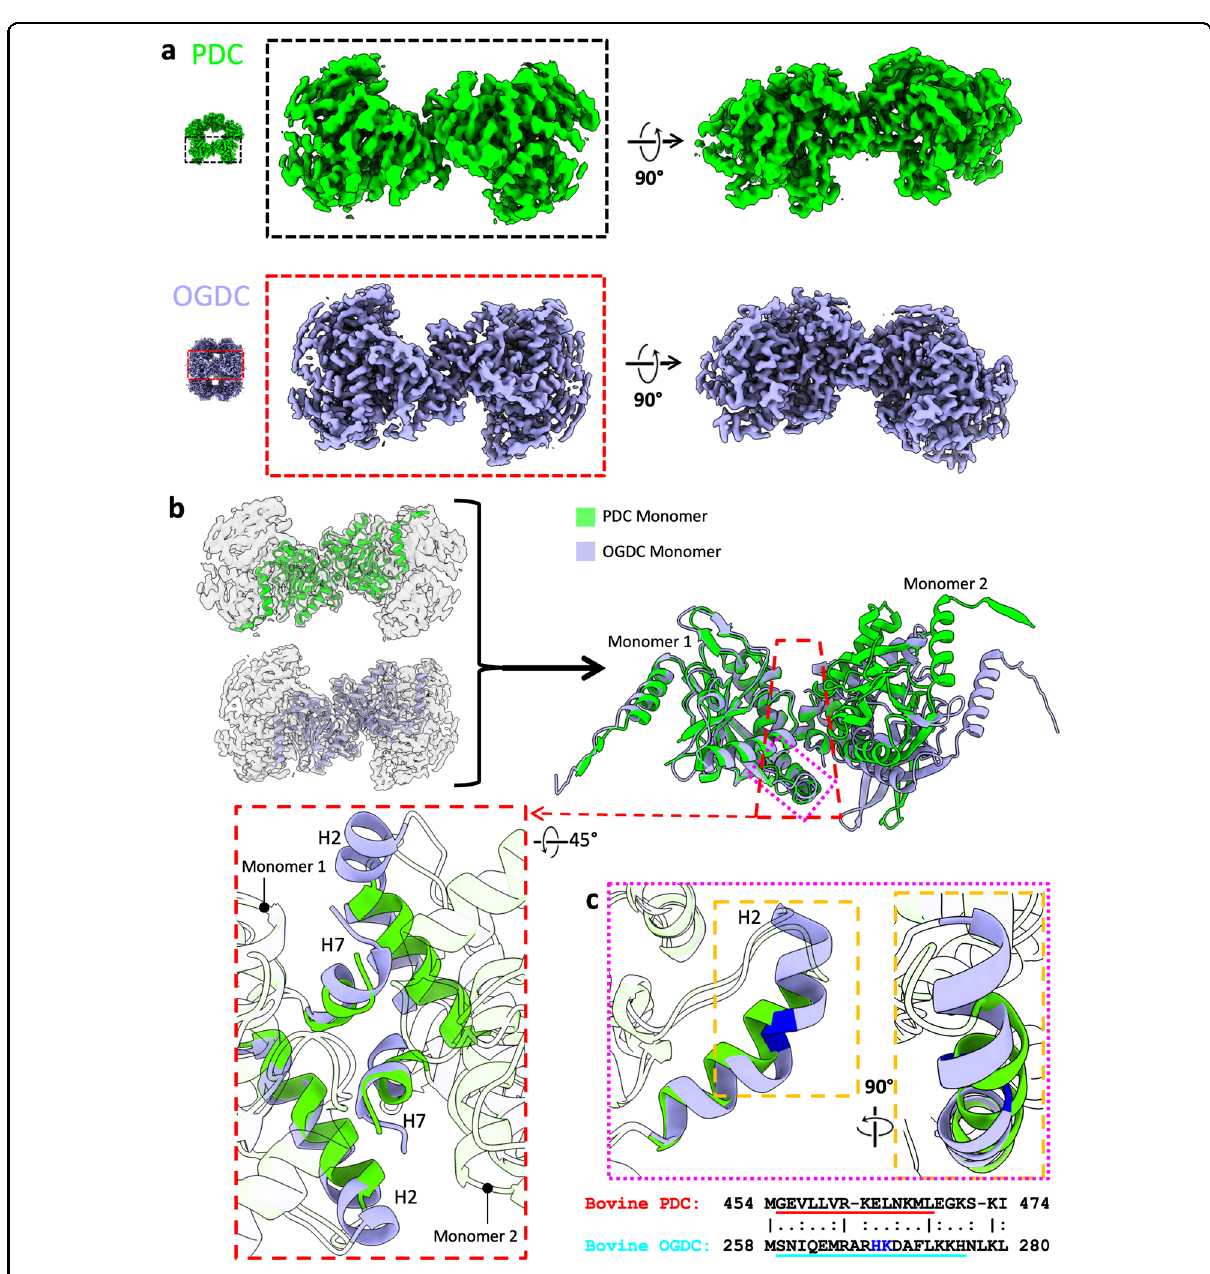
Fig. 6 Differences in the E2 intertrimer interactions between PDC and OGDC. a Two orthogonal views (perpendicular and parallel to the twofold axis) of interacting E2 trimers from the cryo-EM density maps of PDC (green) and OGDC (blue). b Comparison of the intertrimer interface in PDC (green) and OGDC (blue). Interactions involve only two subunits, one from each trimer, as apparent from the left panel where the atomic models (ribbons) of the interacting subunits are superposed in their respective densities. The two interacting subunits shown in a are aligned through their left subunit (monomer 1) and shown together to identify differences at the interacting interfaces with boxed regions shown as insets to highlight differences of their corresponding H2 helix. The inset in red box shows the knob-and-socket interaction of H2 and H7 (colored; rest of ribbon transparent for clarity) at twofold interface in E2p and E2o. c Superimposition and sequence alignment of H2 in E2p and E2o. The helix – kink – helix (kink highlighted in blue) is present in E2o but absent in E2p. Inset in the orange box: enlarged orthogonal view of the diverging H2